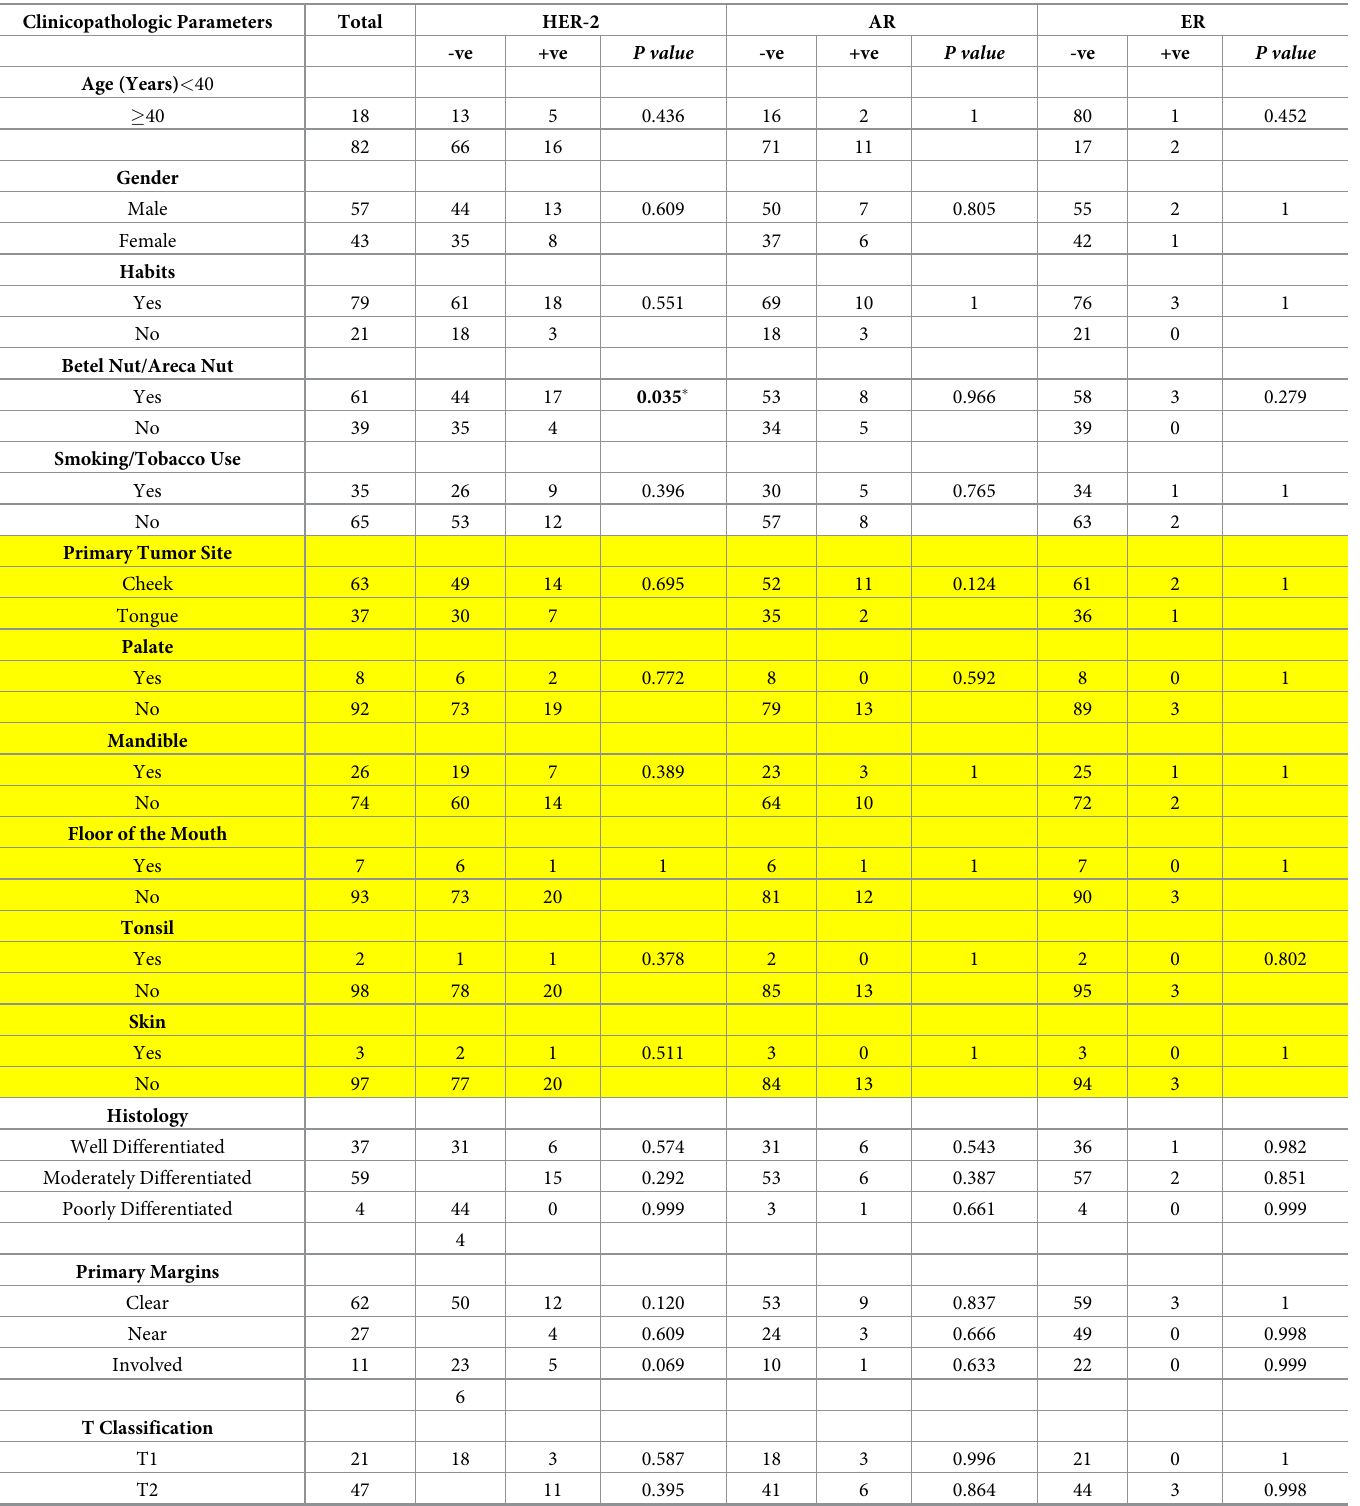
Table 1. Clinicopathologic parameters correlated with Her-2, AR and ER expression. Clinicopathologic